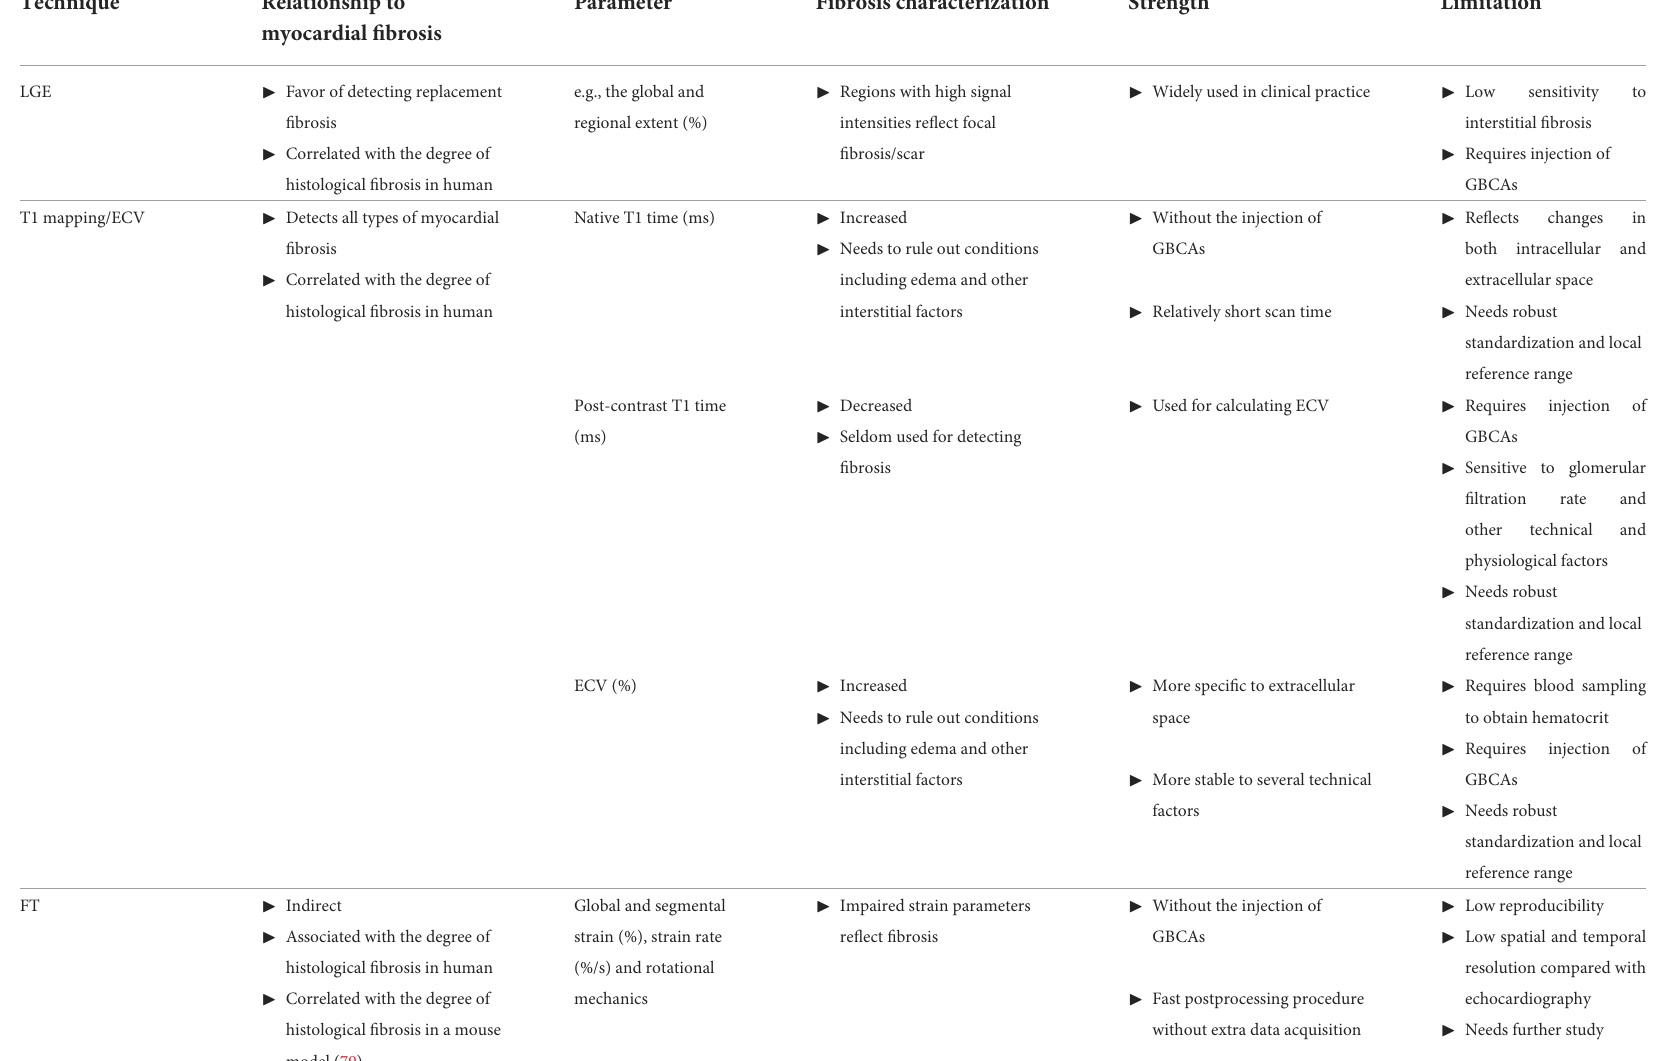
TABLE 1 Various techniques of cardiovascular magnetic resonance for detecting myocardial